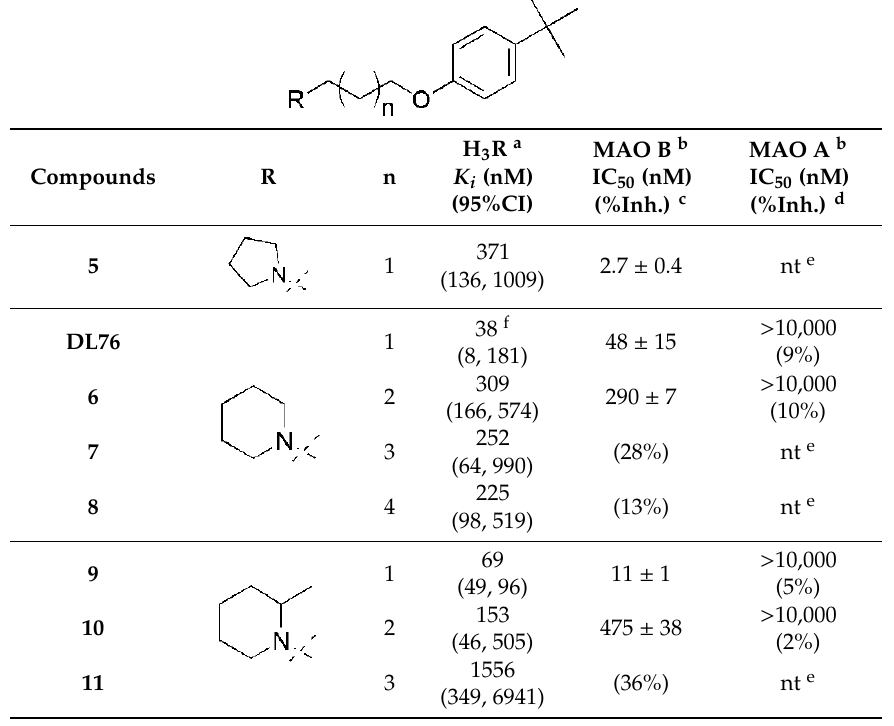
Table 1. Human histamine H 3 receptor affinity and human MAO B inhibition of tested compounds 5–31 and DL76 .